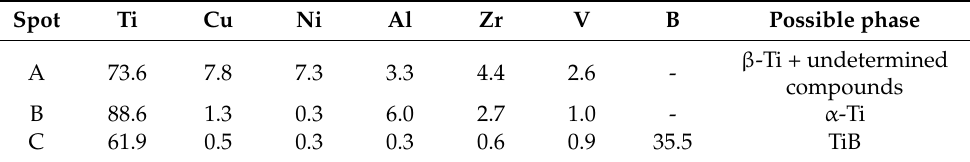
Table 2. Chemical composition (wt.%) and possible phase of A, B, C spots marked in Figure 2b.